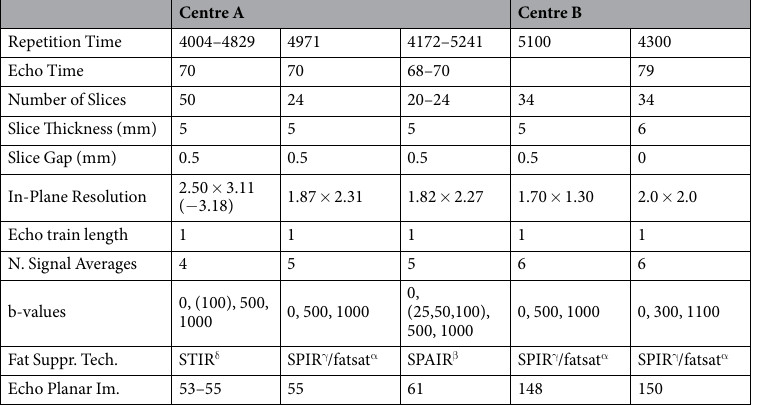
Table 2. Sequence parameters of the diffusion-weighted imaging used during the study period. α Fat Saturation, β Spectral Attenuated Inversion Recovery, γ Spectral Pre-saturation with Inversion Recovery, δ Short T1 Inversion